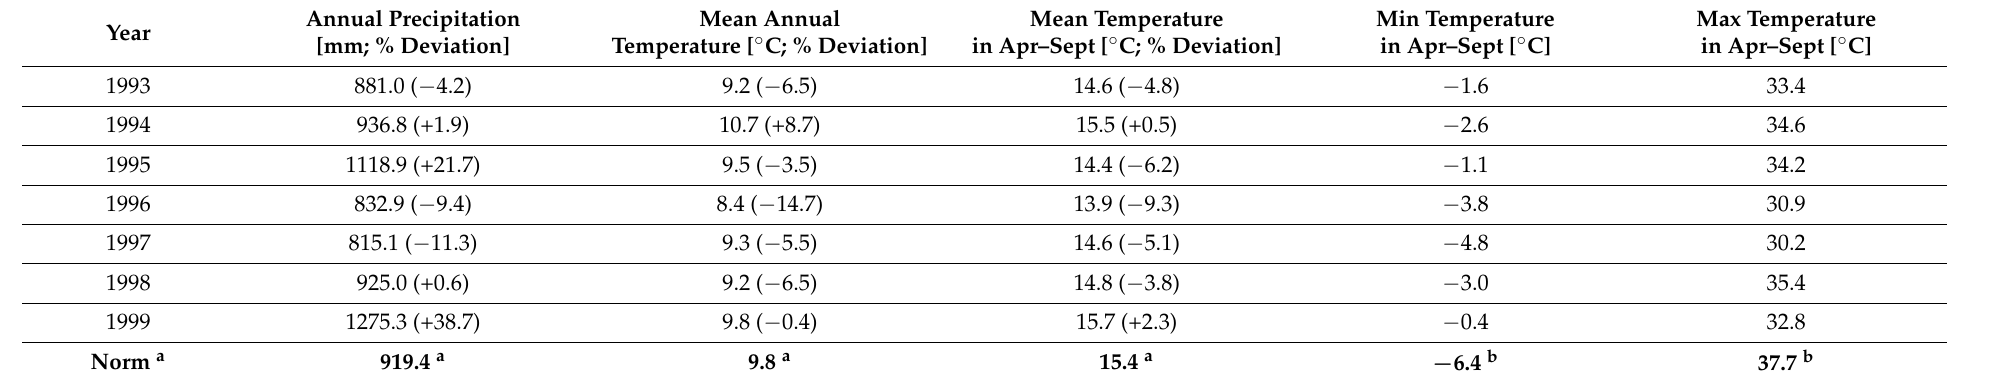
Table 1. Climatic conditions in the years of the study compared with the norm conditions (mean values from 1991–2020). Data on precipitation and temperature from the weather station in Del é mont close to the sites in Movelier and Vicques are presented (data obtained from MeteoSwiss [29]). Percent deviation from norm values are shown in brackets a,b .